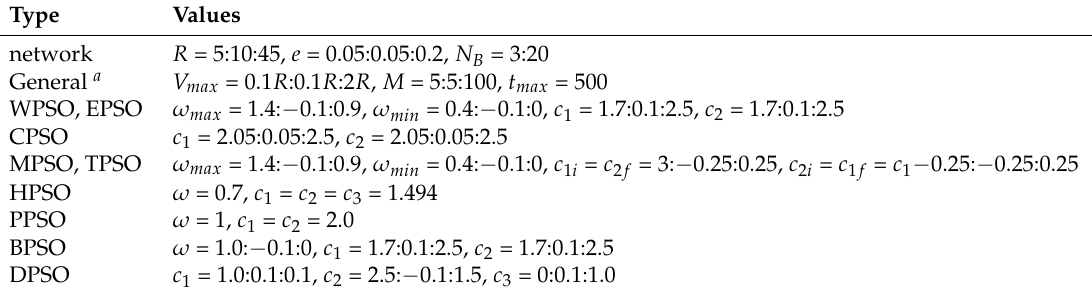
Table 2. Simulations setup. CPSO: Constricted PSO; DPSO: Dynamic PSO; EPSO: Extremum disturbed and simple PSO; MPSO: PSO with particle migration; TPSO: PSO with time variant ω , c 1 , and c 2